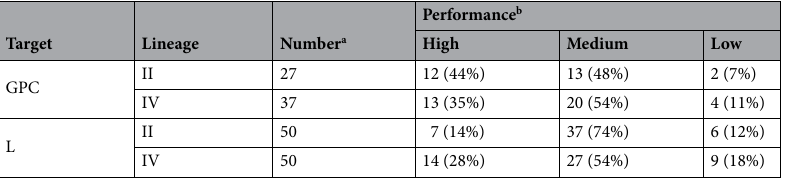
Table 1. Results of crRNA performance testing. a The number of crRNAs tested, b crRNAs were classified into three groups based on the integrated, background subtracted, fluorescent signal relative to the highest signal obtained. Three performance classes were defined: high performance (with signal at 80% or higher), intermediate (signal lower than 80% but higher than 20%) and low (signal at 20% or lower).